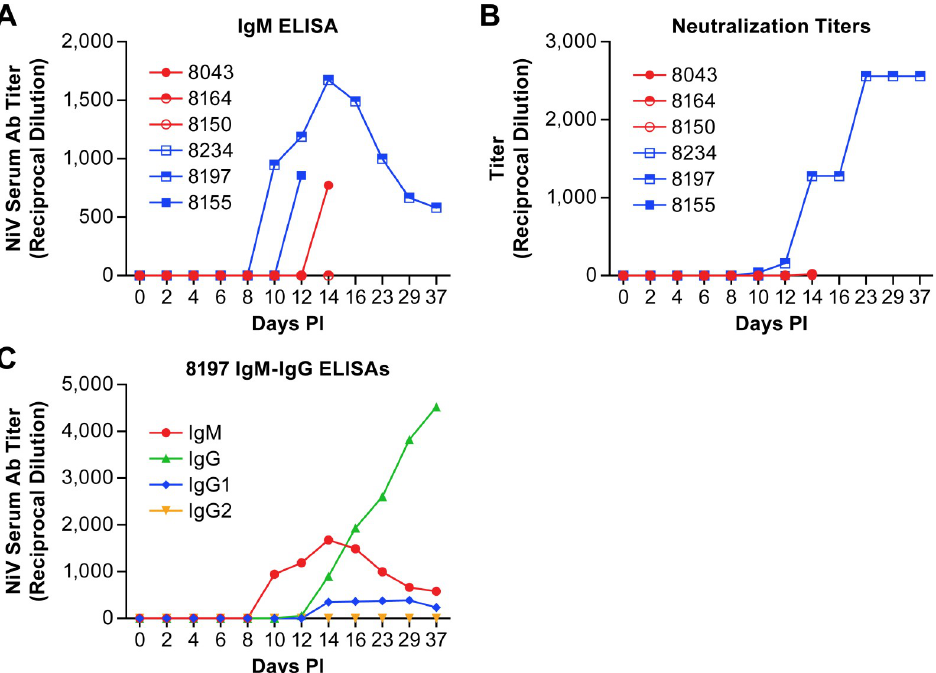
Fig 1. Antibody titers in plasma from AGMs infected with NiV. IgM (A) and neutralization titers (B) from individual animals infected with NiV over the course of disease. Animals in the low dose group are displayed as red circles and those in the high dose group as blue squares. IgM and IgG titers (C) from the animal that survived NiV infection.